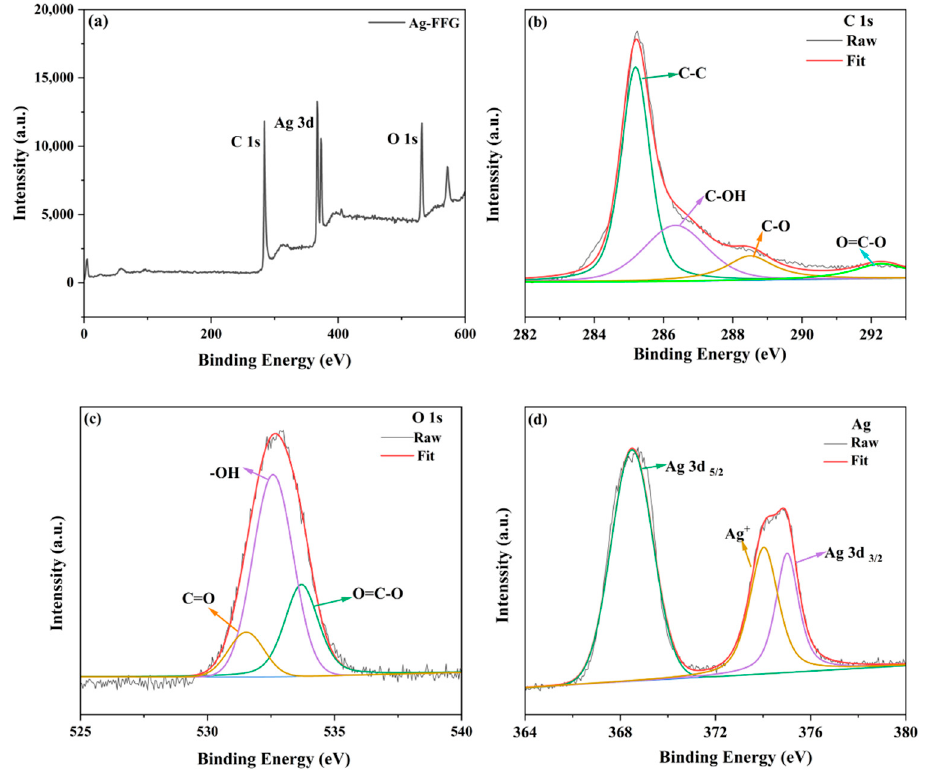
Figure 6. XPS characterization of AgFFG. ( a ) XPS survey spectra of AgFFG; ( b ) high-resolution C1s XPS spectrum; ( c ) high resolution O1s XPS spectrum of AgFFG; ( d ) high-resolution Ag3d XPS spectrum of AgFFG.